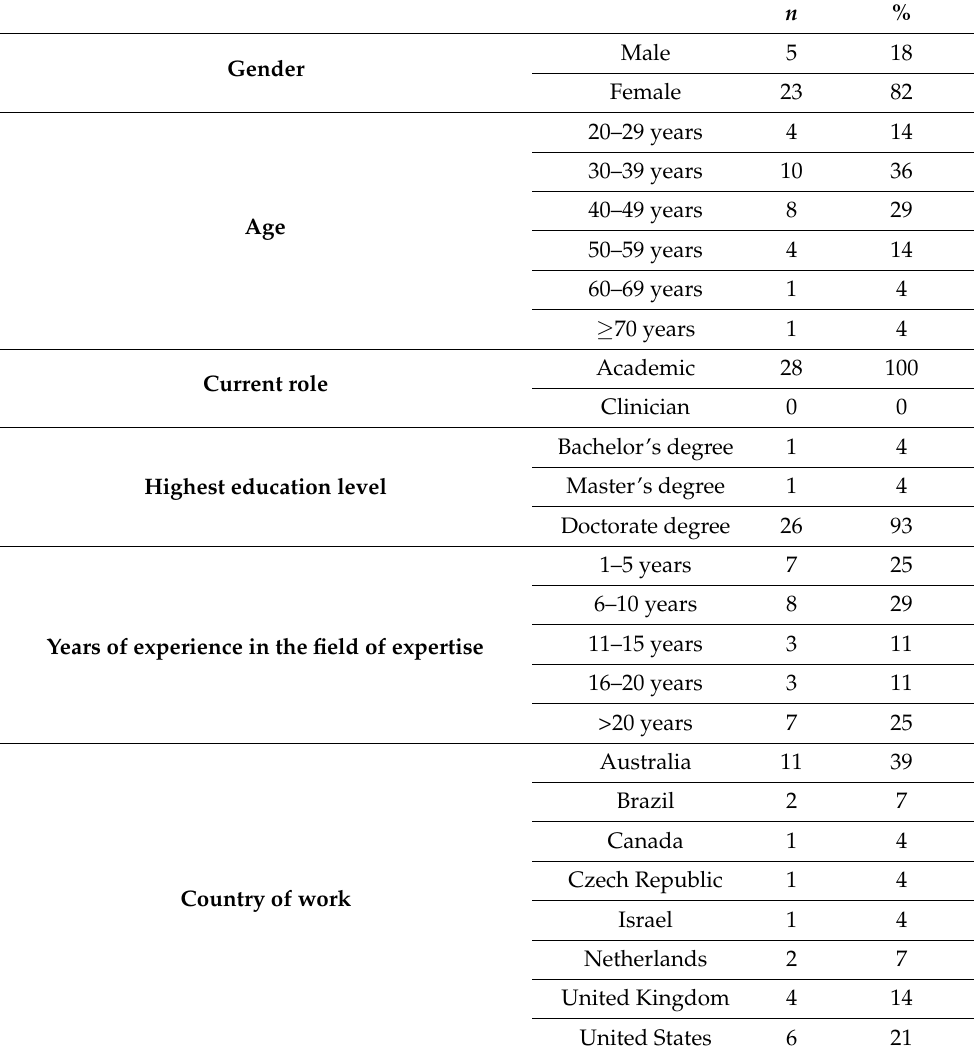
Table 2. Demographics of the expert